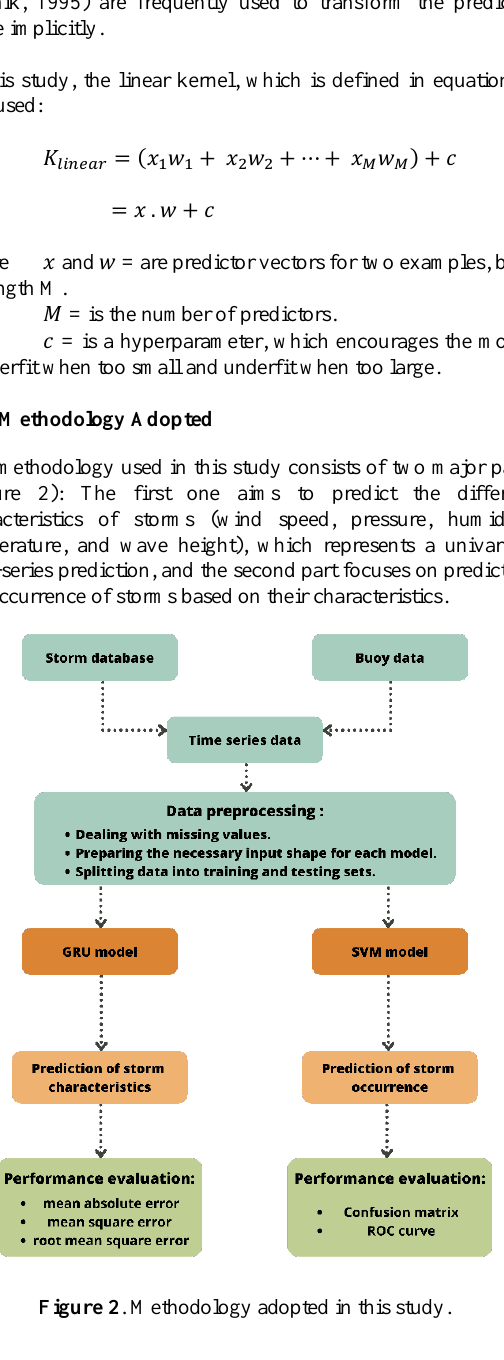
Figure 2 . Methodology adopted in this